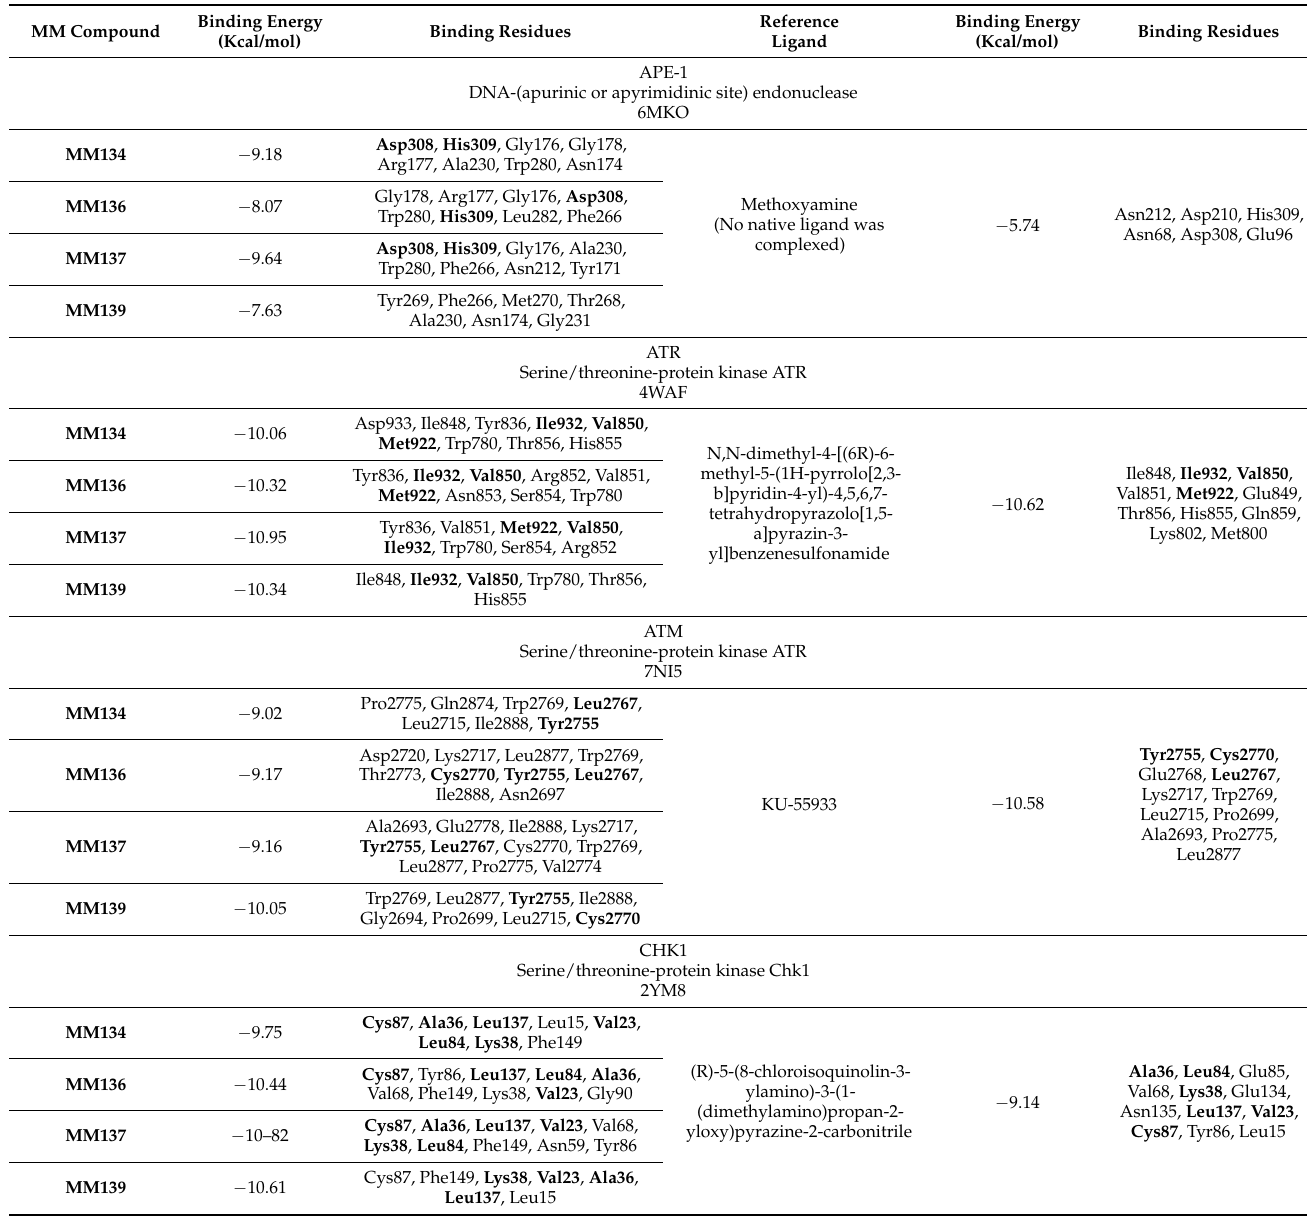
Table 1. Molecular docking results: the results of molecular docking studies of MM compounds and reference ligands against macromolecular structures of proteins involved in the DDR pathway. The common binding residues for MM compounds and reference ligands are